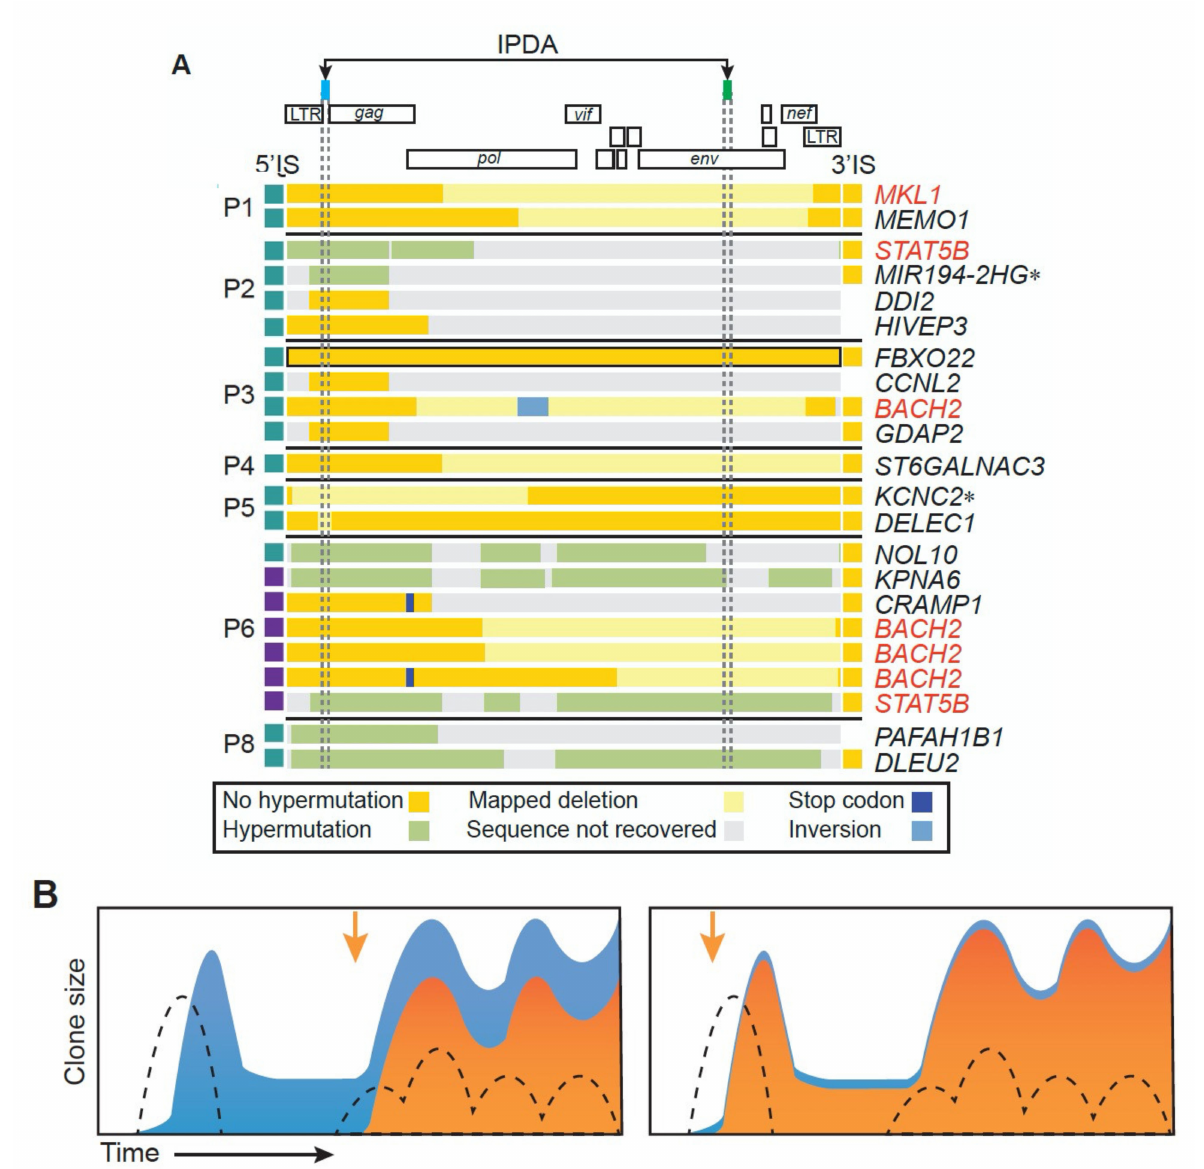
Figure 7. Antigen-driven clonal expansion. ( A ) Structures of proviruses reported by Simonetti et al. [60] in clonally expanded cells obtained from the on-ART donors indicated on the left are shown schematically, along with the gene in which the provirus was integrated. Genes shown in red are ones in which proviruses can confer a selective advantage (Table 1). The 2 regions marked “IPDA” have been found to be commonly deleted or hypermutated in defective proviruses and are the basis for the selective Intact Provirus Detection Assay [61]. CD4+ T cell clones containing the proviruses shown were reactive to one of two common antigens associated with HIV infection, as shown in the boxes to the left of the provirus: CMV (teal), or HIV Gag (purple). ( B ) Schematic showing the importance of the relative timing of antigen stimulation and integration on the frequency of cells in a specific HIV-infected T-cell clone. The dotted lines show the relative concentration of stimulating antigen (CMV or HIV, in this case). Solid blue indicates the total size of the specific antigen-reactive CD4+ T cell clone, and the solid orange indicates the proportion of cells in that clone that carry a provirus descended from a cell infected at the time shown by the orange arrow. Note that the time of infection relative to the origin of the CD4+ T cell clone is reflected by the fraction of the cells with a specific rearranged T cell receptor that contain a provirus at a specific integration site. Copyright 2021 American Society for Clinical Investigation